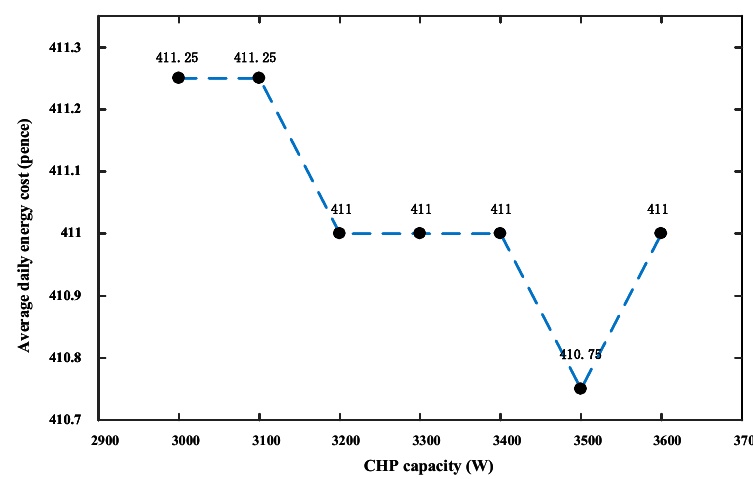
Figure 14. Average daily energy costs within theoretical best gas engine CHP capacity region.